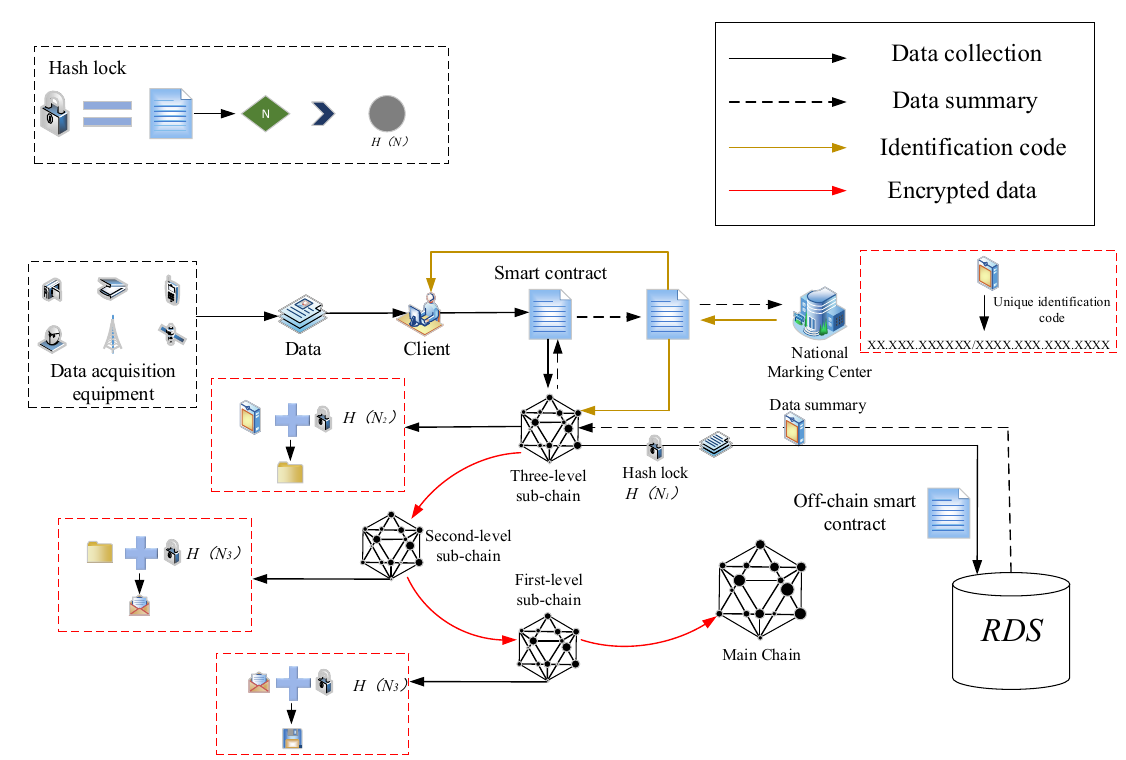
Figure 4. Schematic diagram of multi-level sub-chain encryption mechanism.